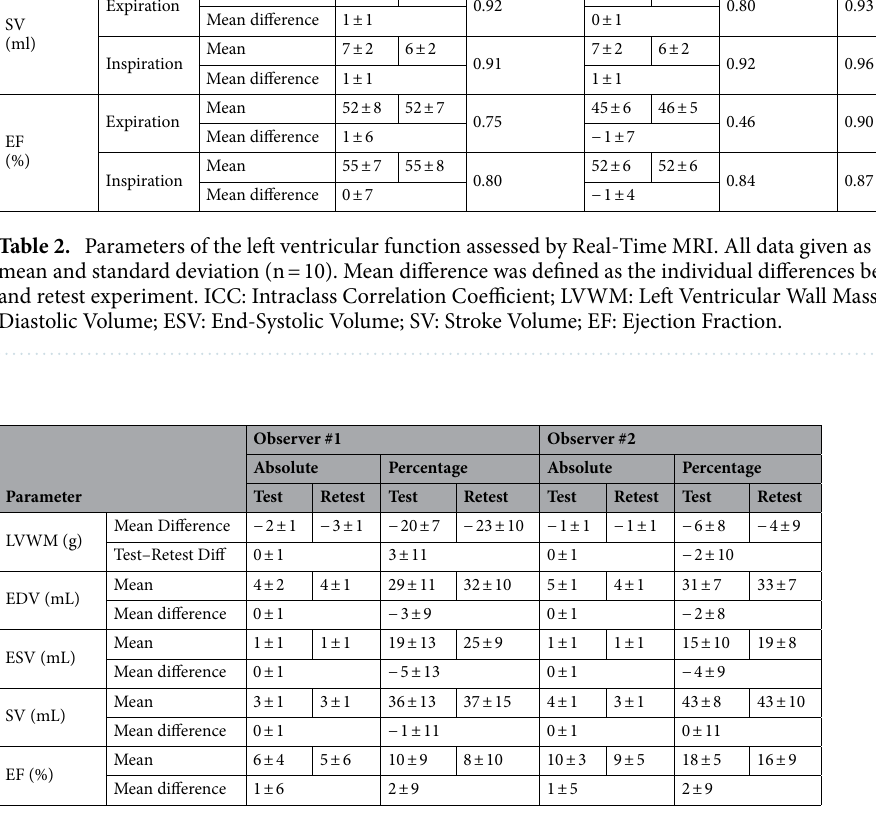
Table 3. Difference between cine MRI and Real-Time MRI. All data given as arithmetic mean and standard deviation (n = 10). Mean difference and test–retest difference were defined as the individual differences between cine MRI and Real-Time MRI, and between test and retest experiment, respectively. LVWM: Left Ventricular Wall Mass; EDV: End-Diastolic Volume; ESV: End-Systolic Volume; SV: Stroke Volume; EF: Ejection